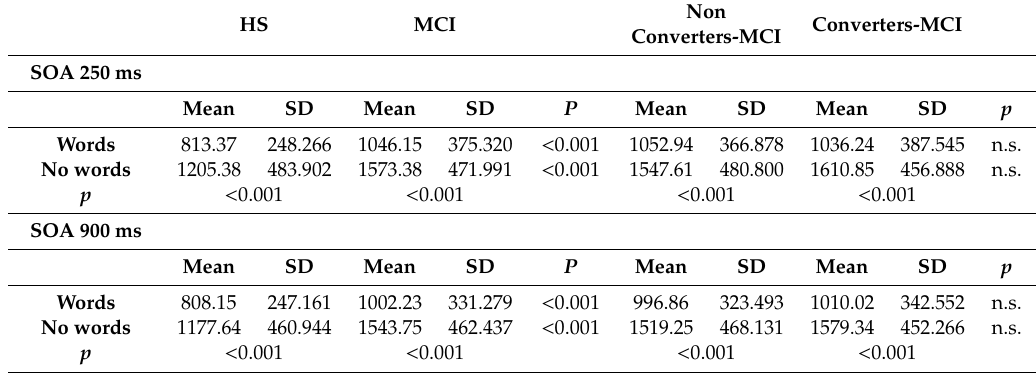
Table 1. Lexicality e ff